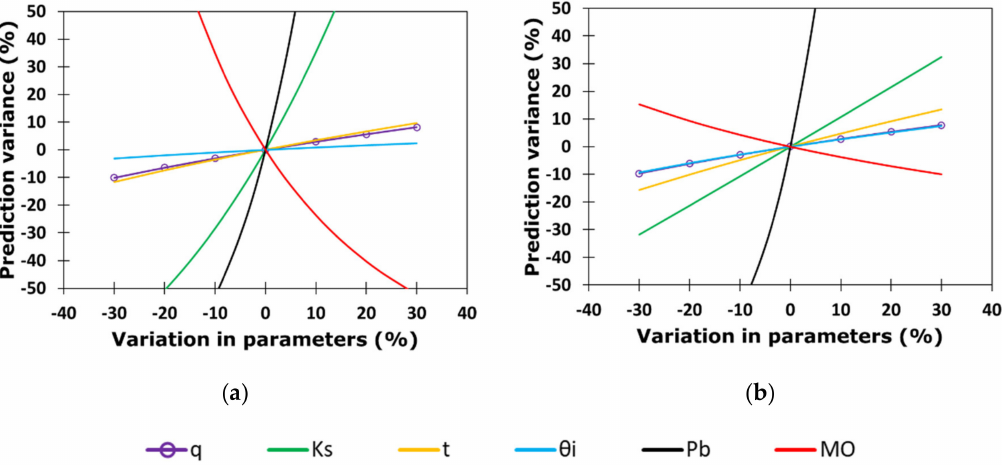
Figure 10. Effect of input parameters on the response of the proposed models for ( a ) width and ( b ) depth of the wetting